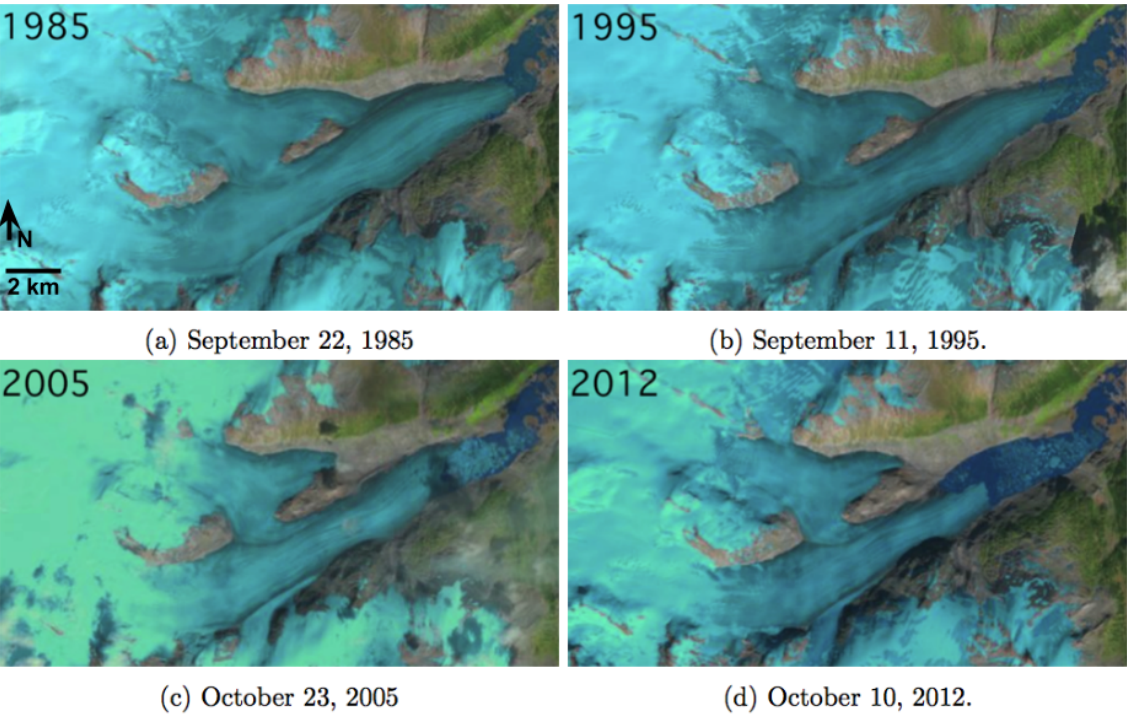
Figure 2. Landsat imagery from 1985 to 2012, showing retreat of Bridge Glacier and opening of Bridge Lake. All images have the same orientation and scale as the upper left